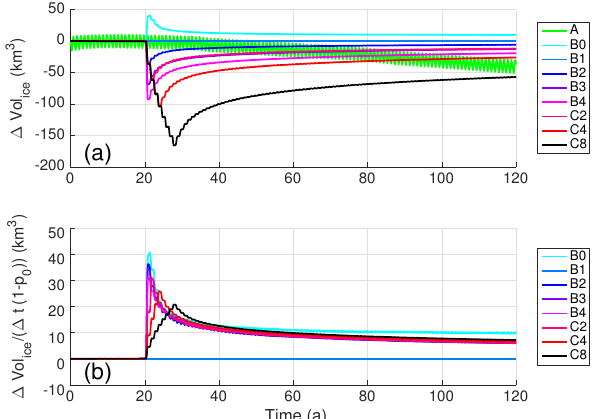
Figure 8. (a) Absolute difference in ice volume for the different simulations with respect to experiment B1. The non-oscillating ice volume profile of experiment A causes its difference to experiment B1 to oscillate. (b) The volume differences from experiments B and C divided by (cid:49)t( 1 − p 0 ) , the measure of the time-integrated calving rate